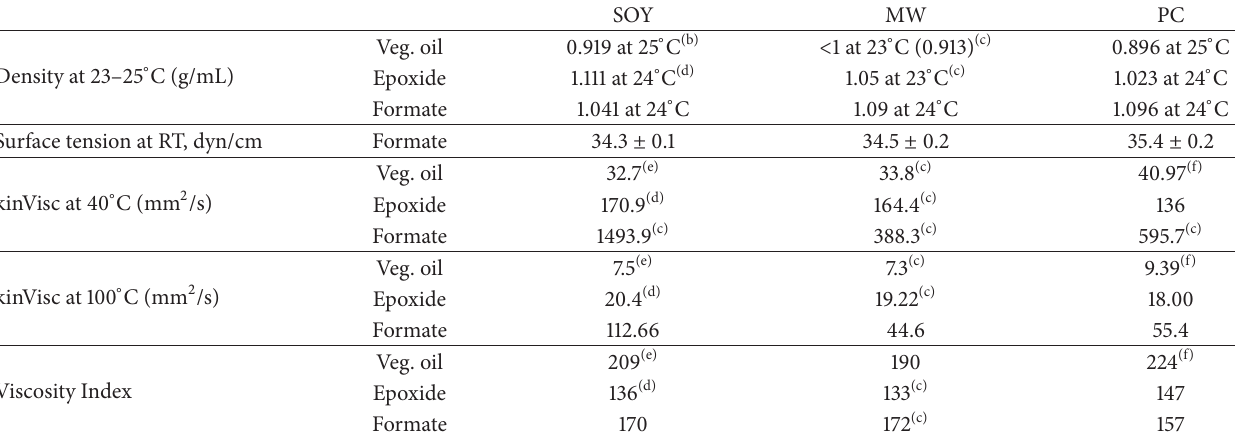
Table 1: Some physical properties of polyformate esters of vegetable oils ( a ) .